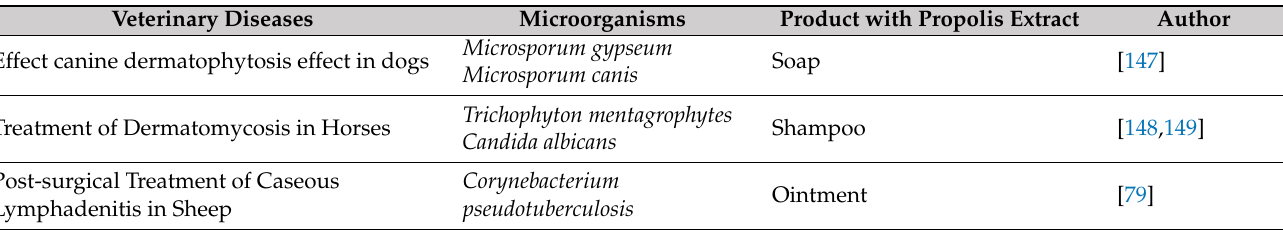
Table 3. Veterinarian products with propolis